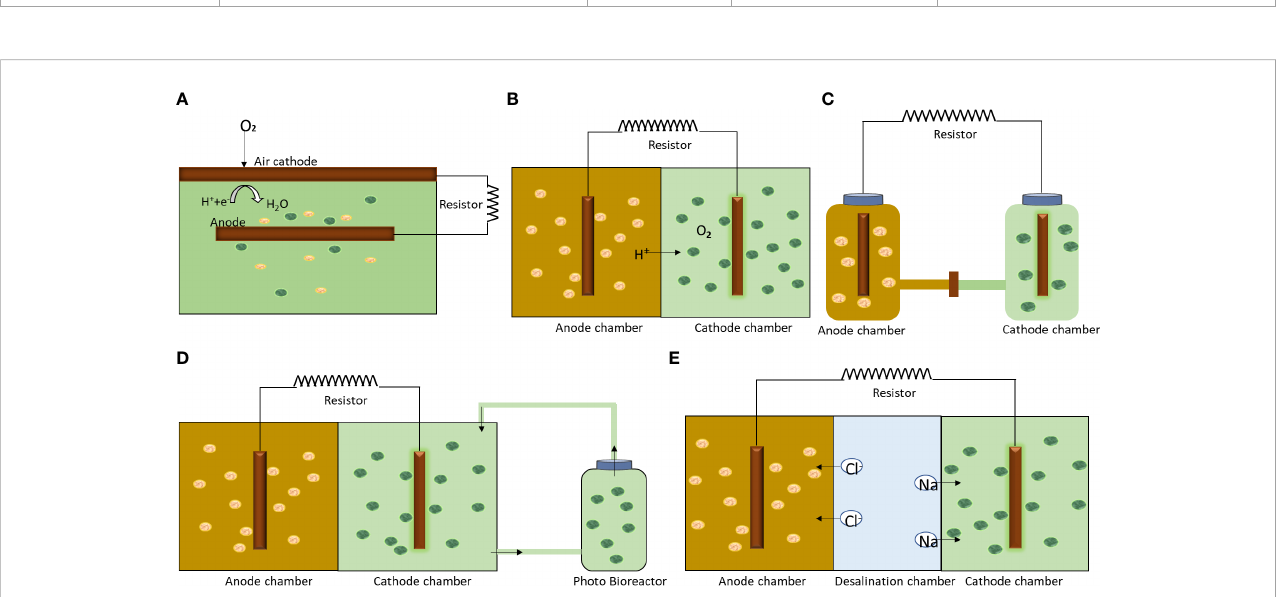
FIGURE 3 Schematic showing different algae assisted MFC con fi gurations (A) single chamber; (B) Dual chamber; (C) H-shaped; (D) dual chamber integrated with external photobioreactor and (E) three chamber with